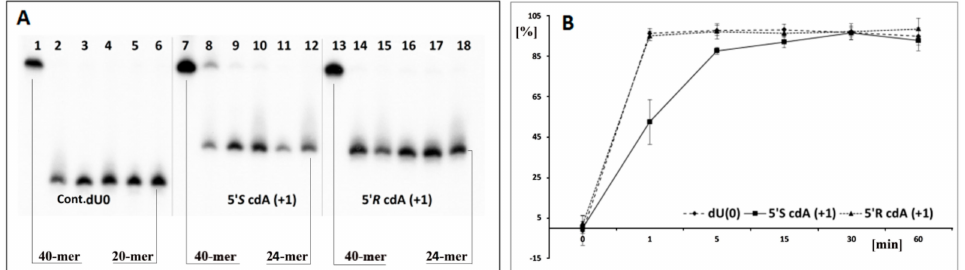
Figure 3. ( A ) Digestion of single-stranded oligonucleotides: Cont.dU(0), ss -ScdA( + 1) and ss -RcdA( + 1) by UDG and hAPE1 with subsequent 1 M piperidine treatment. Lines 1–6 correspond to ss -Cont.dU(0); Lines 7–12 correspond to ss -ScdA( + 1); Lines 13–18 correspond to ss -RcdA( + 1). In all cases, the following order of reaction times was used: 0, 1, 5, 15, 30, 60 min starting from the left site. ( B ) Time scale for dU incision by UDG from ss -DNA containing a cluster lesion (The numeric raw data is presented in the graph, and the average and standard deviation values have been given a separate file in the Supplementary Materials). Sequence of single-stranded 40-mer oligonucleotides given in Table